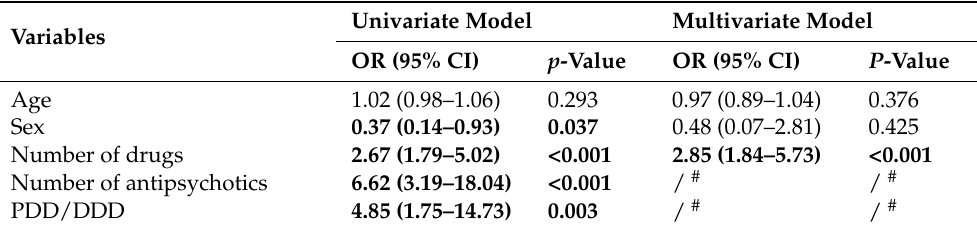
Table 3. Logistic regression analysis based on exposure to potential drug—drug interactions (n = 76).